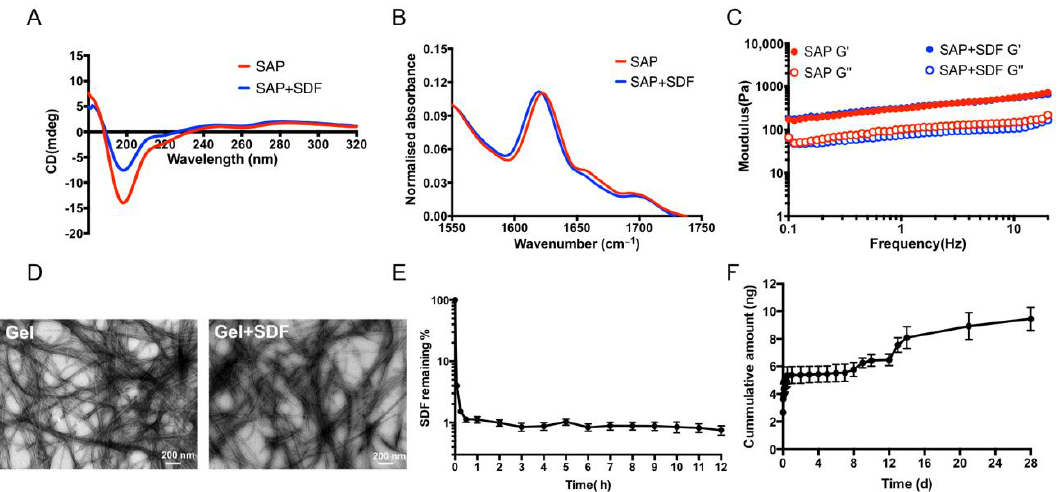
Figure 1. Homeostatic hydrogel maintains its characteristics and supports sustained release of SDF protein. ( A ) Characteristics of hydrogels with/without SDF via circular dichroism (CD), ( B ) Fourier transform infrared (FTIR), ( C ) rheology, ( D ) transmission electron microscopy (TEM), ( E ) recombinant SDF protein degradation in media, ( F ) cumulative release of SDF protein from SAP hydrogel. Data represent mean ± standard error of the mean (SEM).